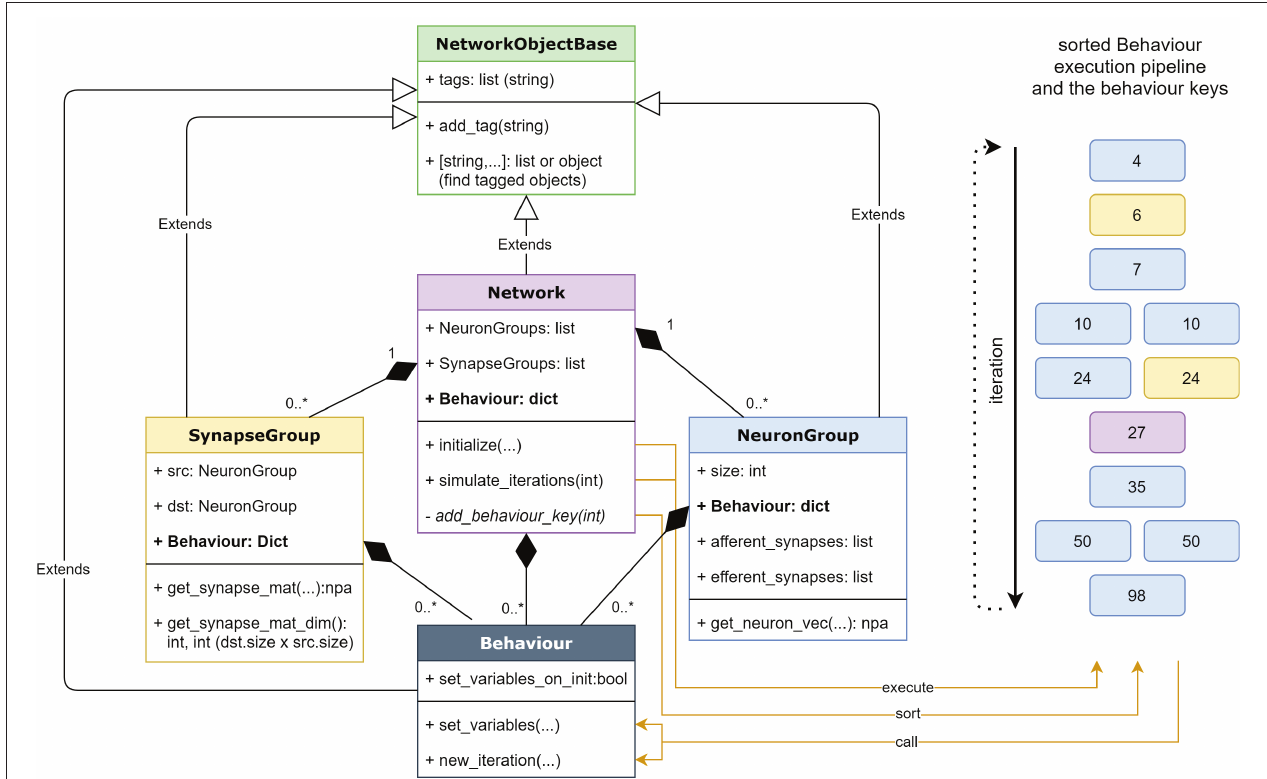
FIGURE 2 | A UML Diagram of PymoNNto’s core with its most relevant variables and functions on the left as well as a visualization of an example execution pipeline composed of sorted behaviours (boxes) on the right. The white arrows indicate inheritance relationships and the black diamonds indicate compositions. The numbers in the execution pipeline represent the keys of corresponding behaviours in the dictionary of their parent object. The colors of these behaviours correspond to the colors of their parents on the left. The orange arrows connect both visualizations and indicate how the functions interact with the execution pipeline. npa, NumPy array.